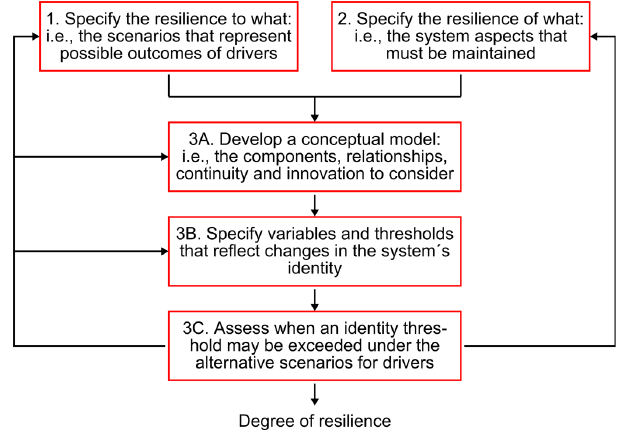
Fig. 1. Flow chart of the identity approach for assessing socio- technical